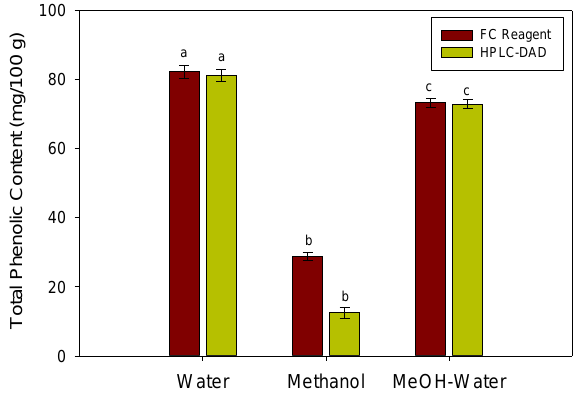
Figure 3. Total phenolic contents (TPC) of the different extracts of melon seeds. Values are mean of triplicate readings. Different letters (a–c) in the same procedure represent significant at p < 0.05 (Holm–Sidak method).